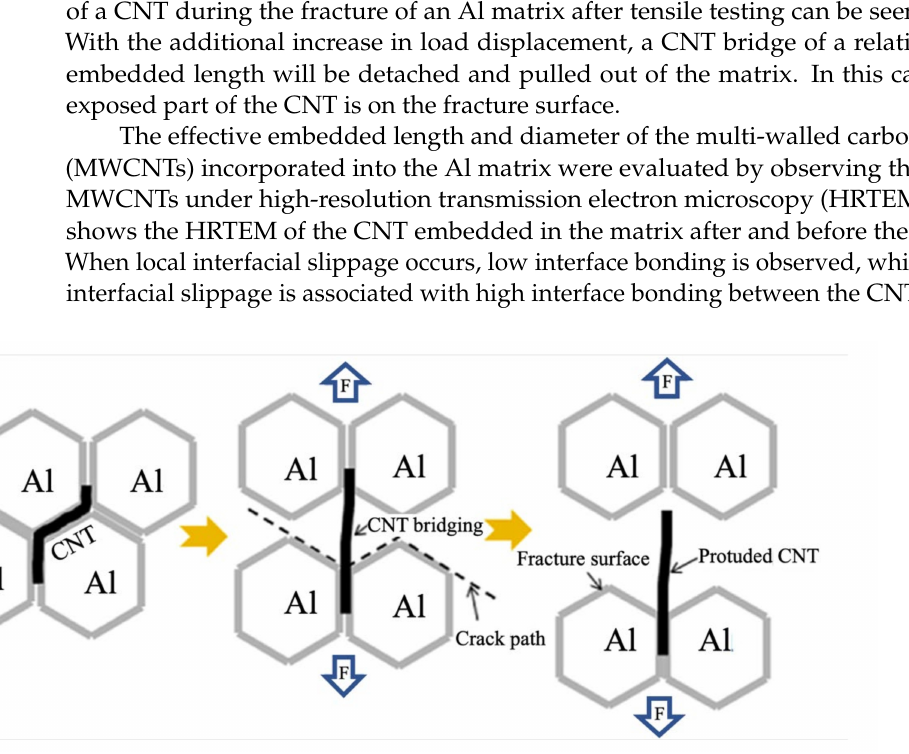
Figure 9. Schematic of a CNT lying on the crack plane partially detached from the matrix. Adapted from [79] with permission from Elsevier,